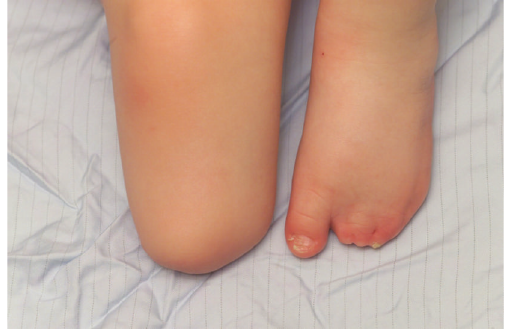
Figure 4: Appearance of right leg after